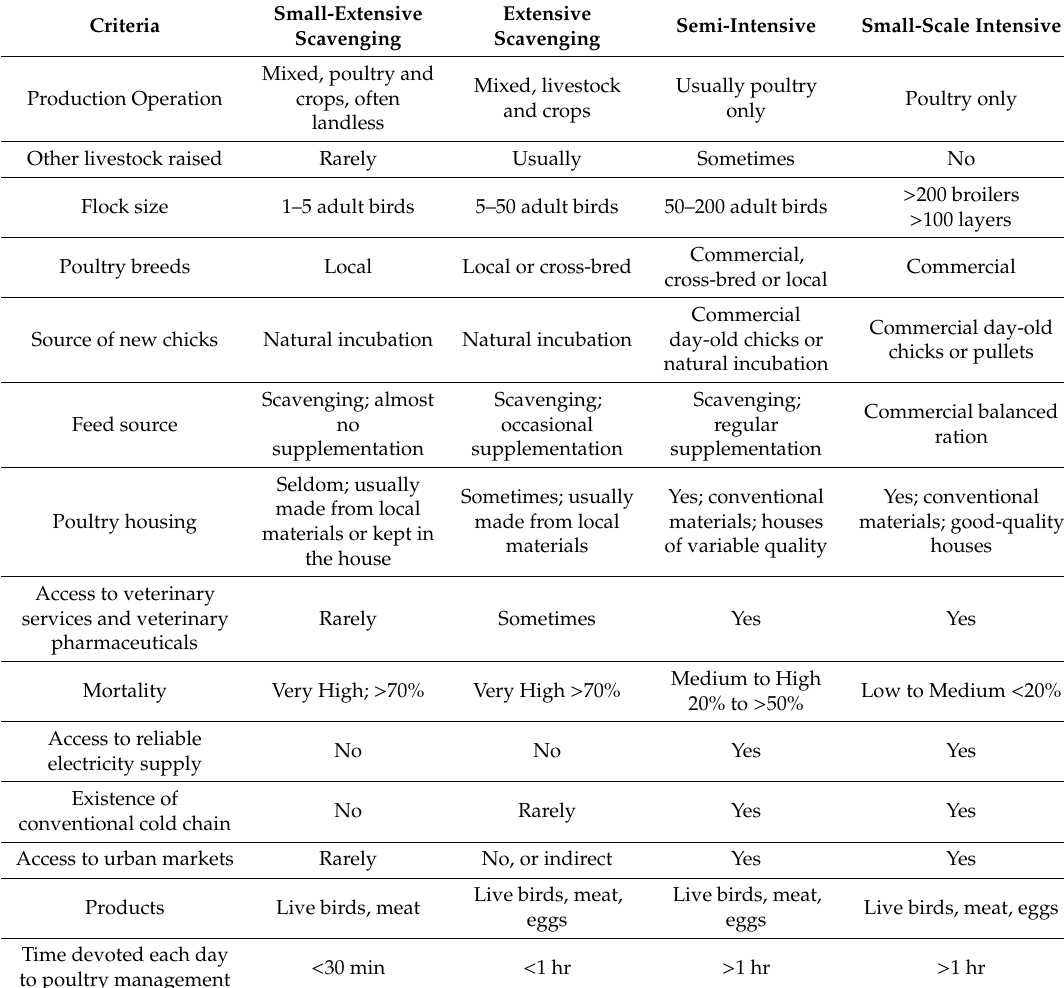
Table 2. Characteristics of family poultry production systems